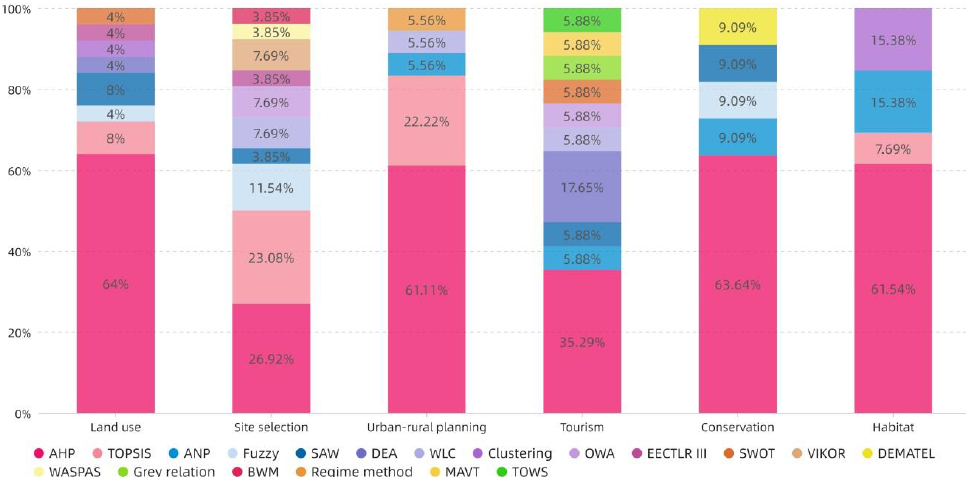
Figure 15. The annual distribution of occurrences of the ranking methods.